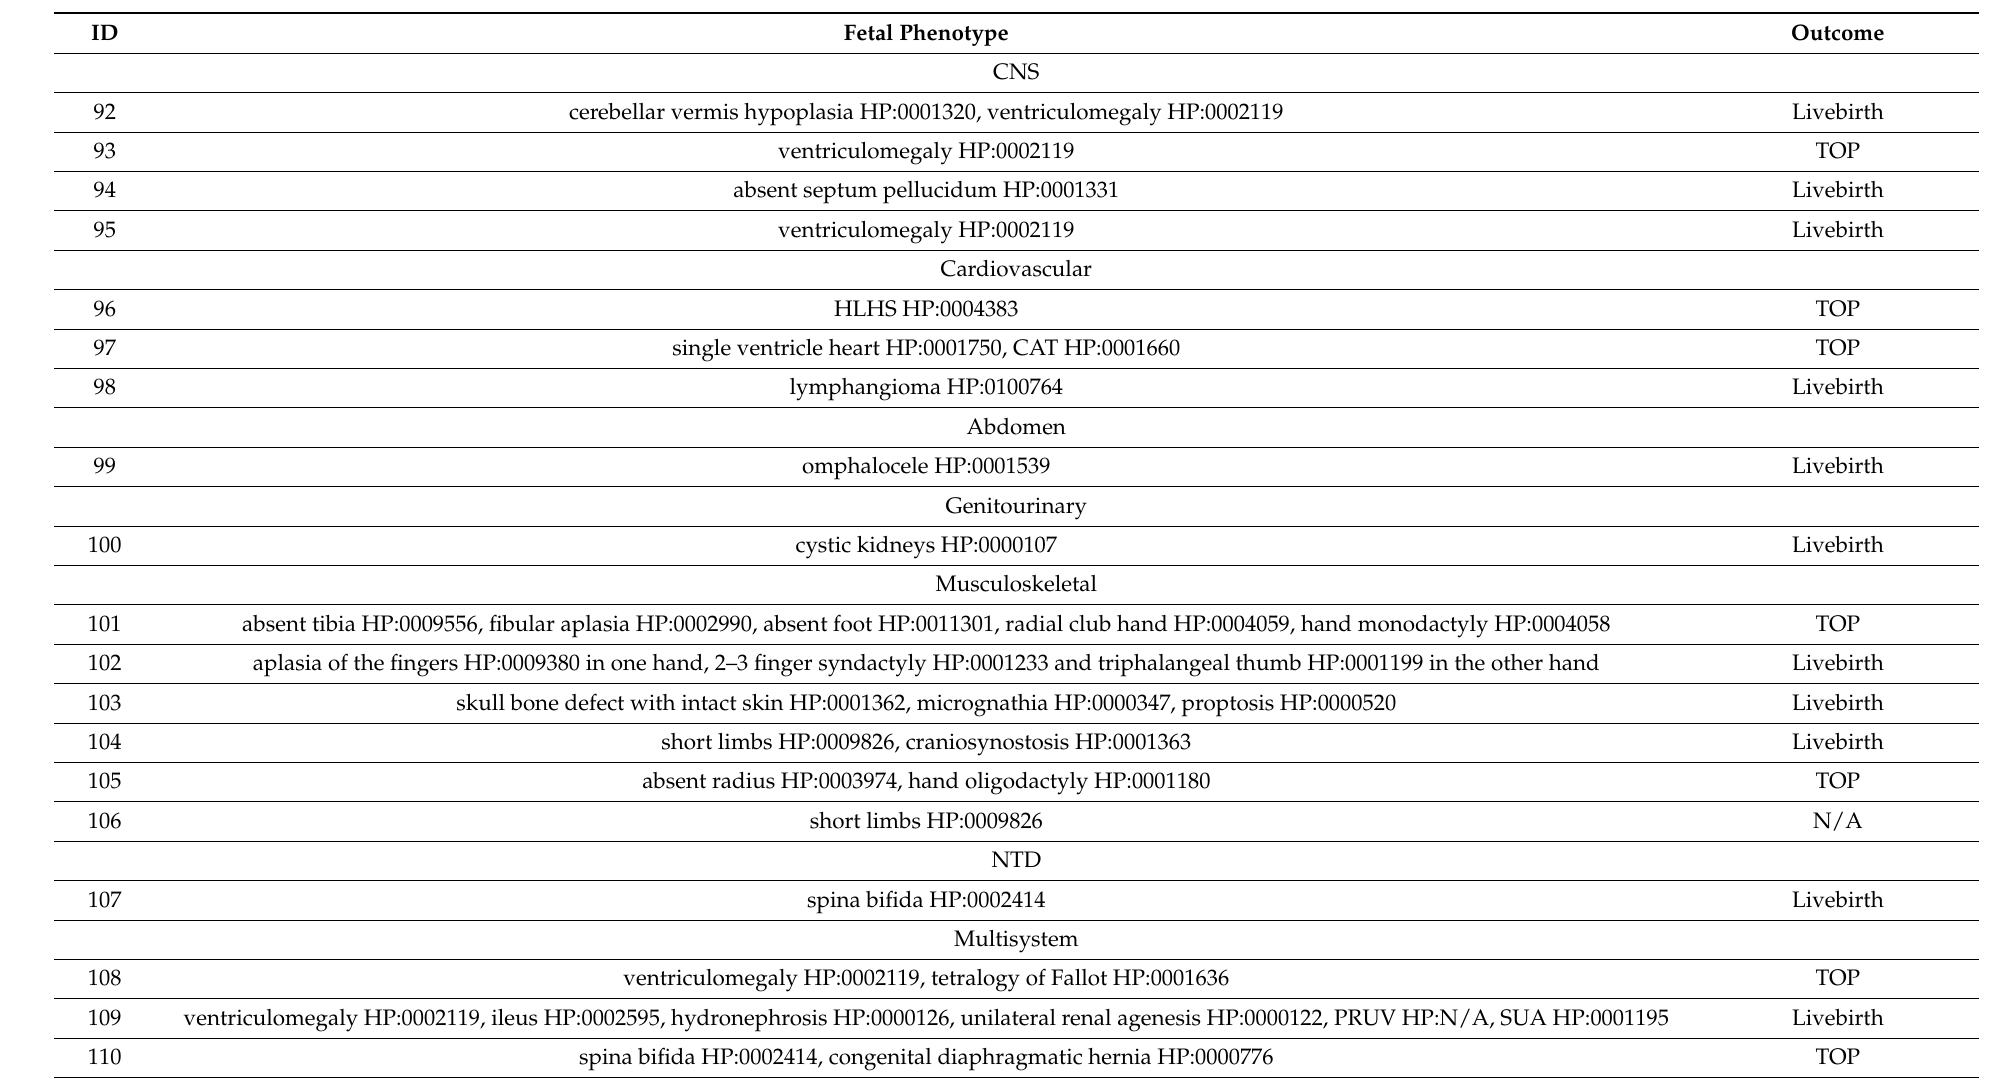
Table 4. Sonographic findings in fetuses with normal ES detected in exome sequencing—detailed